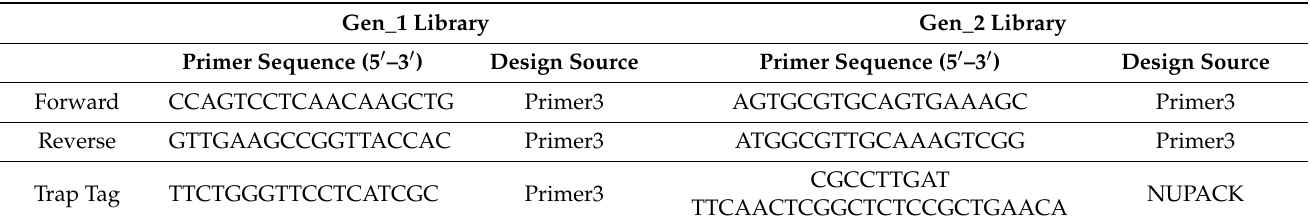
Table 2. Designed Primer